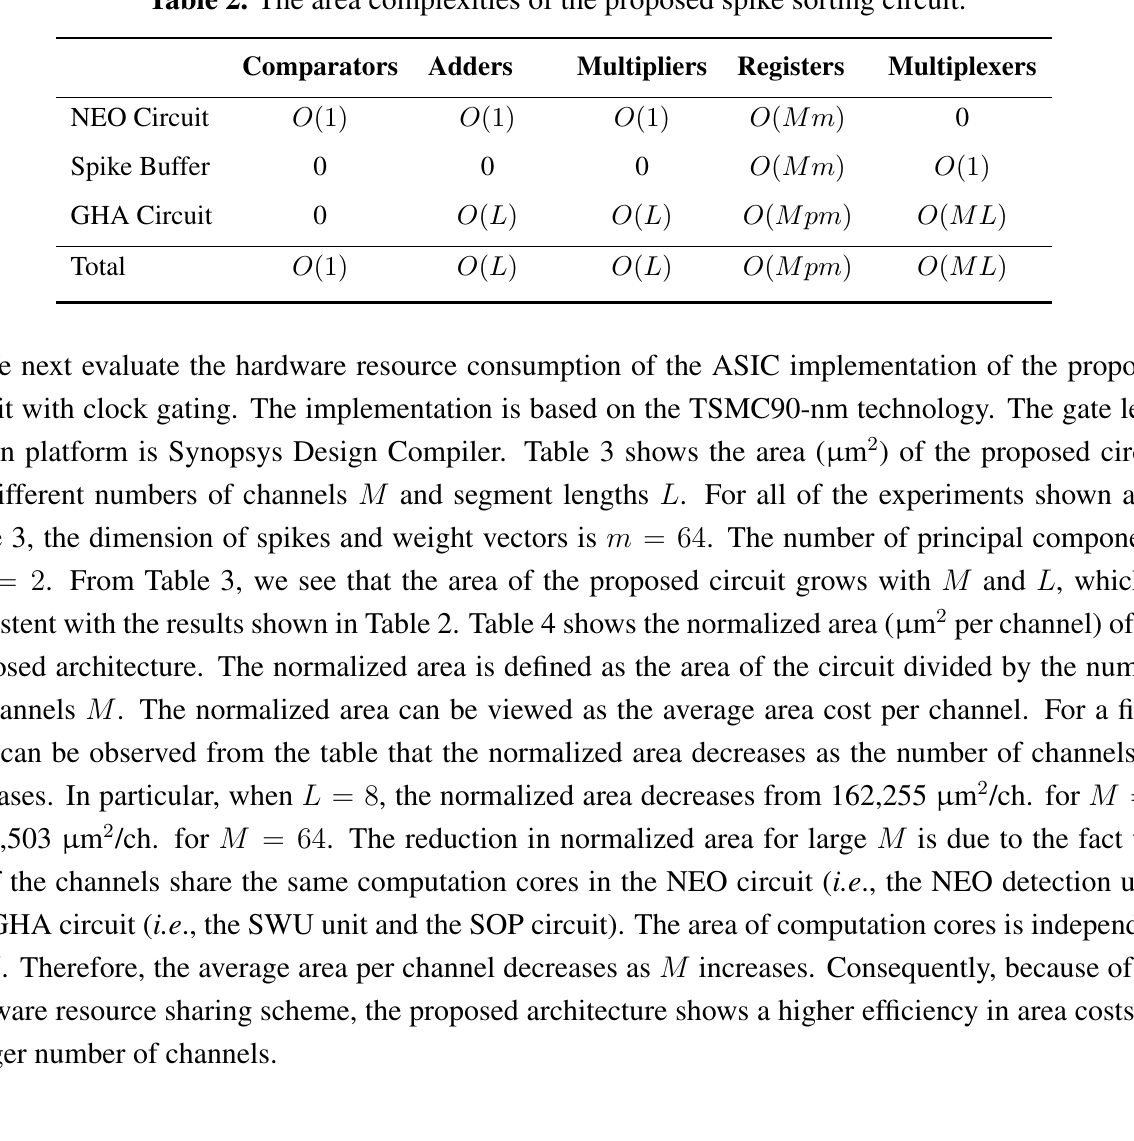
Table 2. The area complexities of the proposed spike sorting